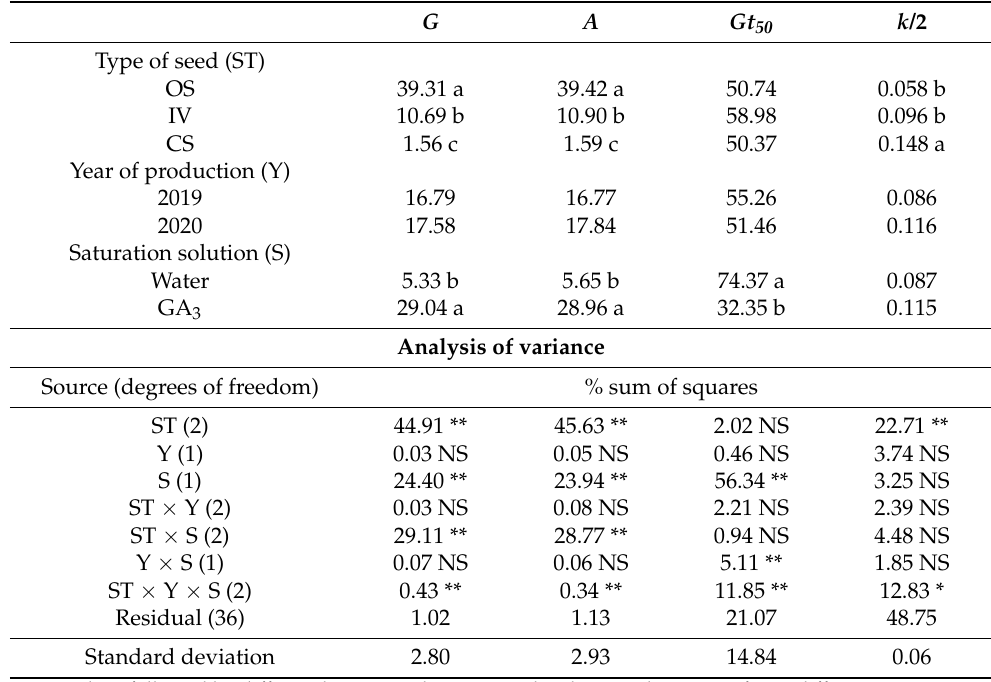
Table 2. Effects of the type of seeds (own produced (OS), type IV, and commercial (CS) seeds), the year of production, and the substrate saturation solution on the germination parameters: cumulative germination ( G , %), final germination percentage ( A , %), time (d) required to reach 50% of final germination ( Gt 50 ), and average germination rate ( k /2; d − 1 ); mean values. G A Gt